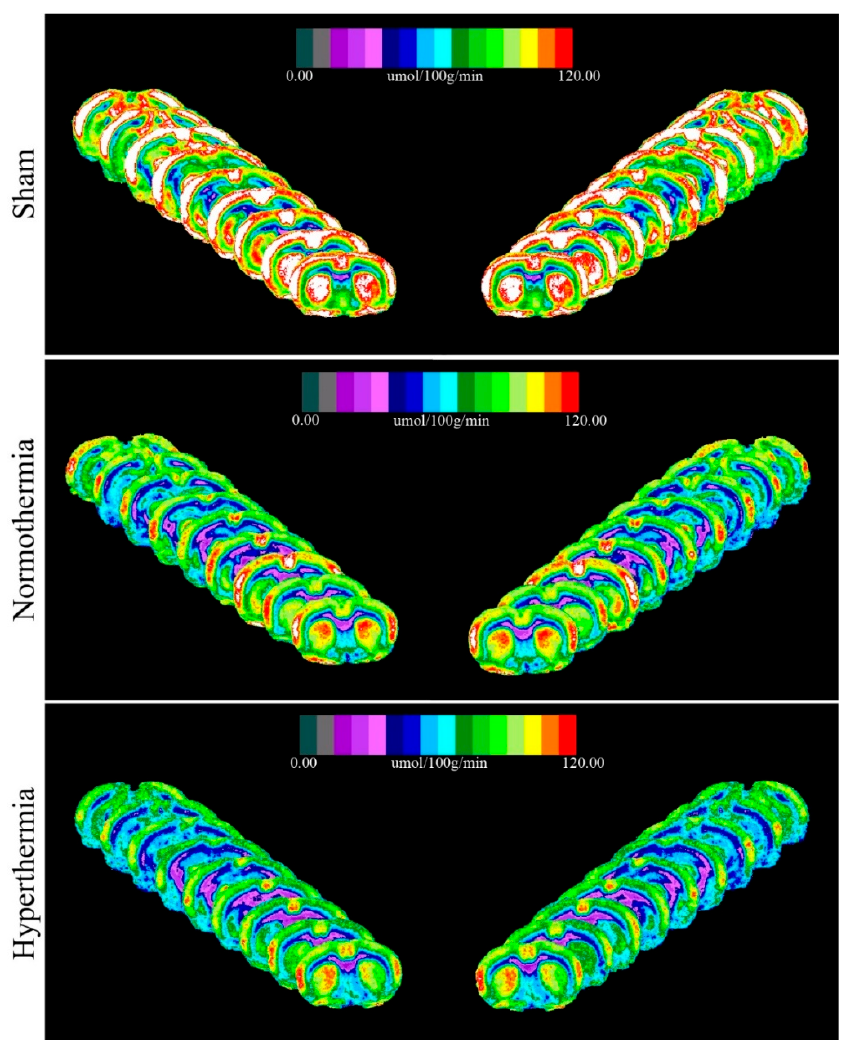
Figure 2. Stacked images of all nine bregma levels in mirrored orientations to show qualitative intergroup differences.